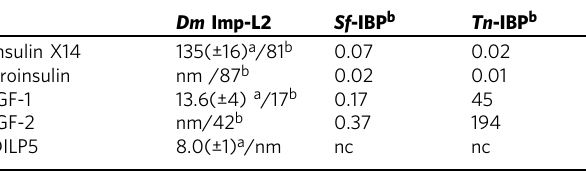
Table 1 Hormone binding data for Imp-L2 and other putative IBPs from Spodoptera frugiperda ( Sf -IBP) and Trichoplusia